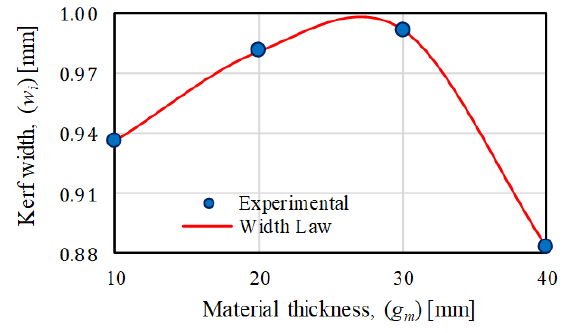
Figure 5. KW variation on bottom region [11]